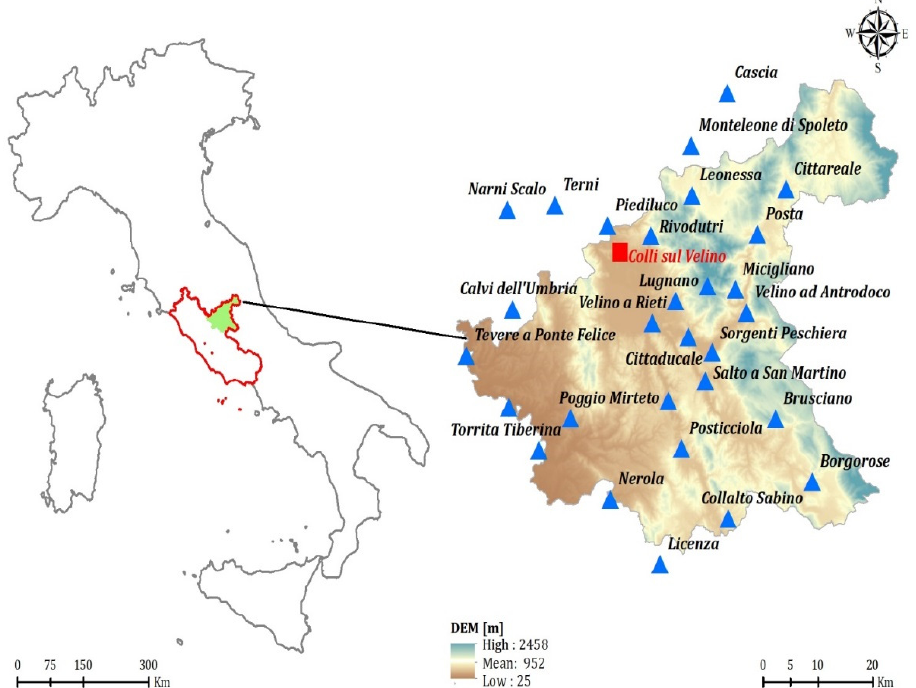
Figure 1. Study area localization. Left: Italy (grey border), Lazio region (red border), Rieti province (filled green). Right: Rieti province digital elevation model (DEM) with rain gauge stations (blue triangles) and Colli sul Velino rain gauge station (red square).